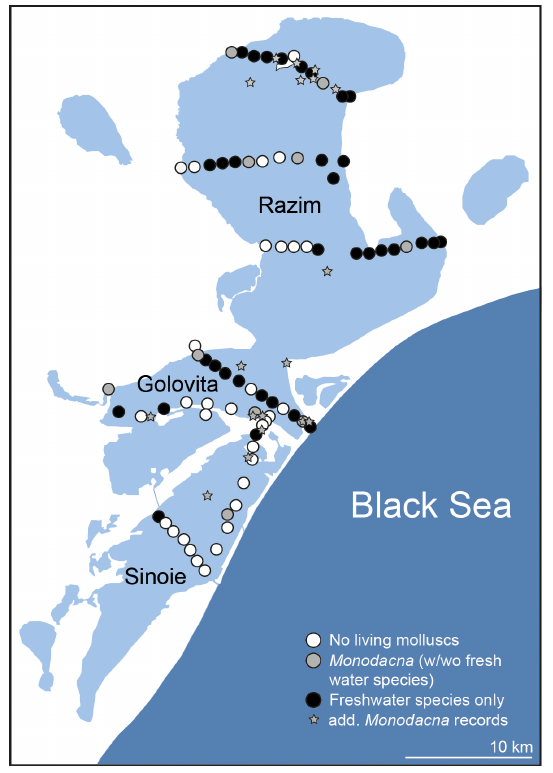
Figure 3. Sampling locations of three expeditions in 2015–2017. The first (September–October 2015) and second expeditions (July 2016) were searching for living Pontocaspian molluscs in particular. The third expedition consisted of six transects sampled by GeoEco- Mar in 2017 in search of any living mollusc. In the legend w/wo means with or